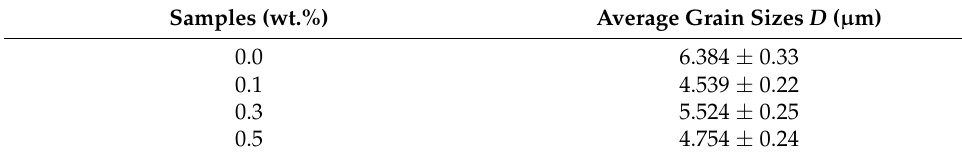
Table 2. The average grain sizes, D of the Y123 with additions of graphene.